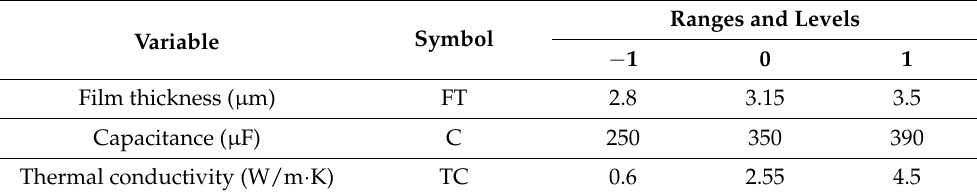
Table 1. Range and levels of experimental parameters.